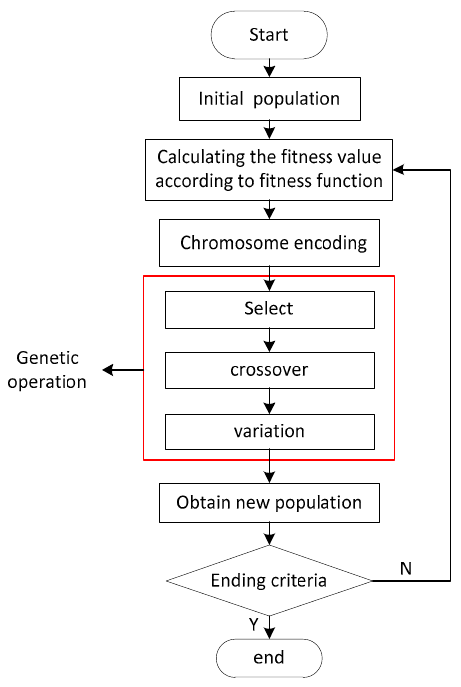
Figure 6. The flow of the genetic algorithm.